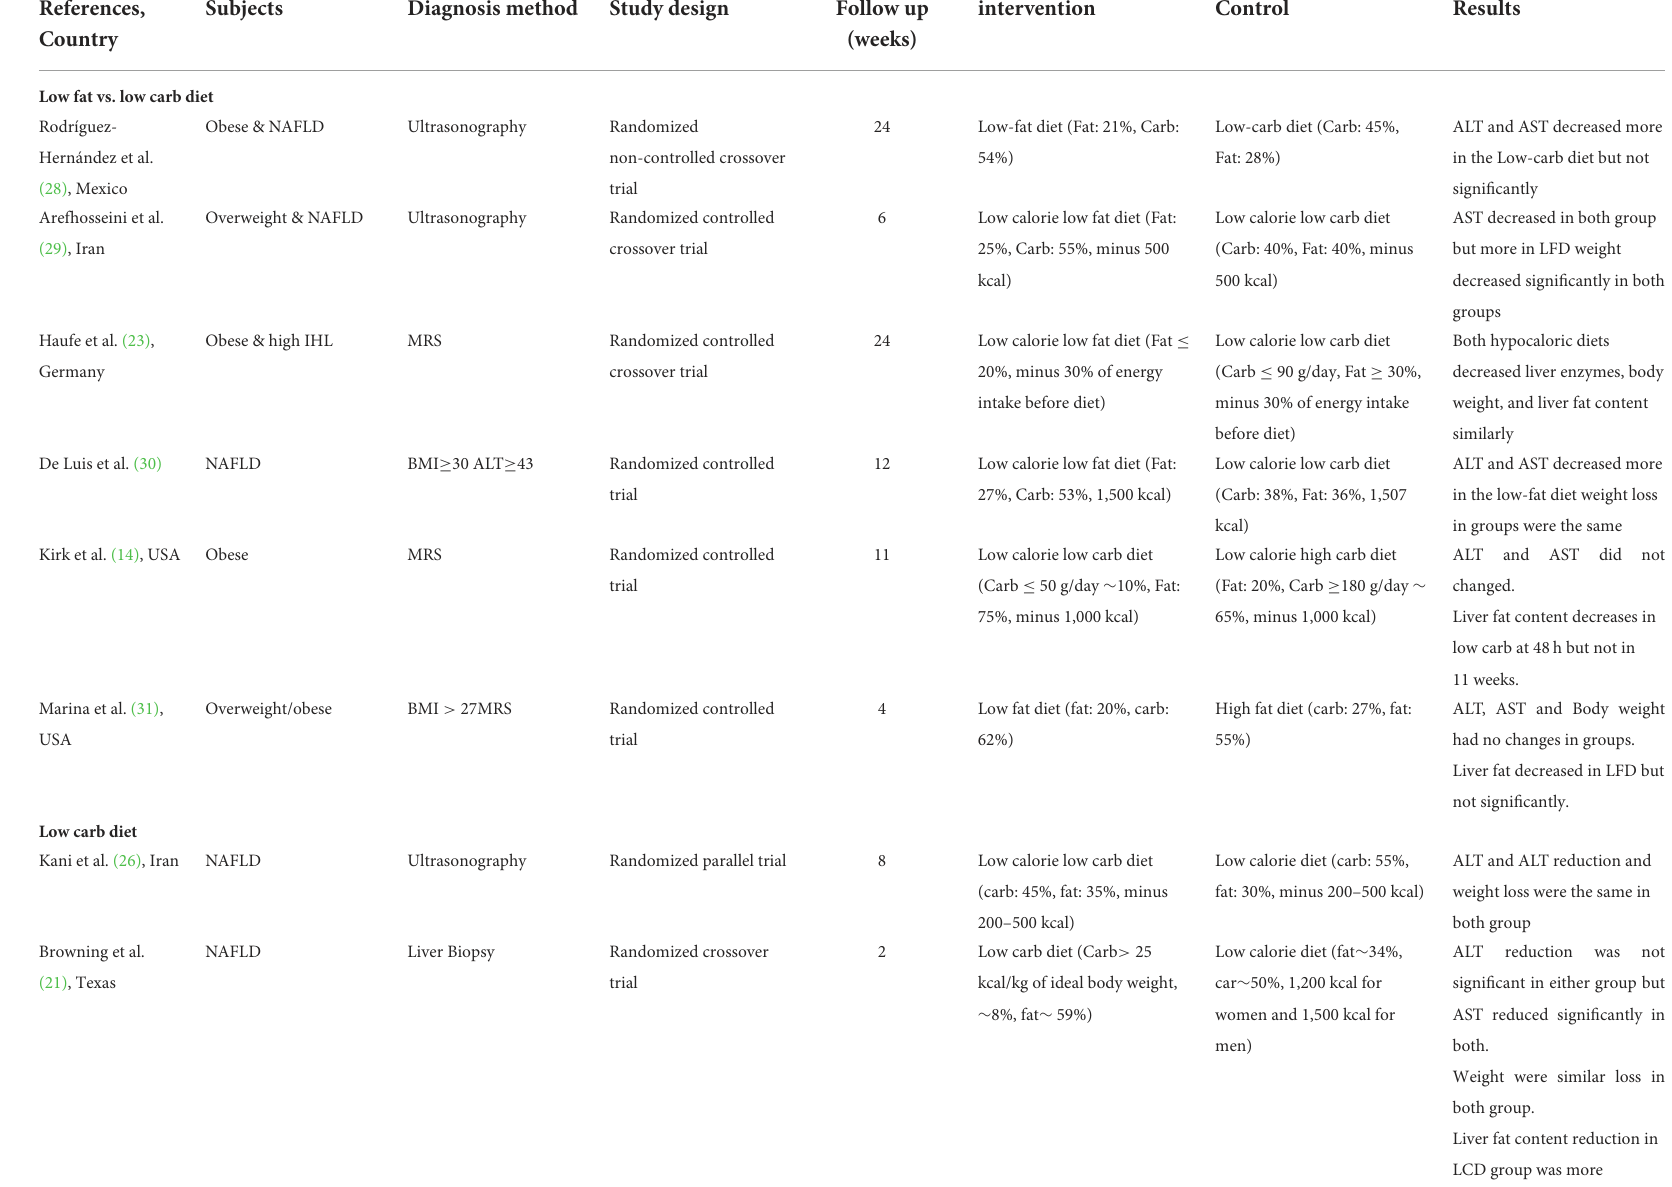
TABLE 2 The characteristics of the 15 eligible